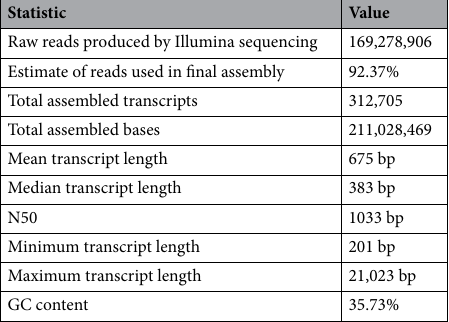
Table 1. Summary statistics for sequencing and transcriptome